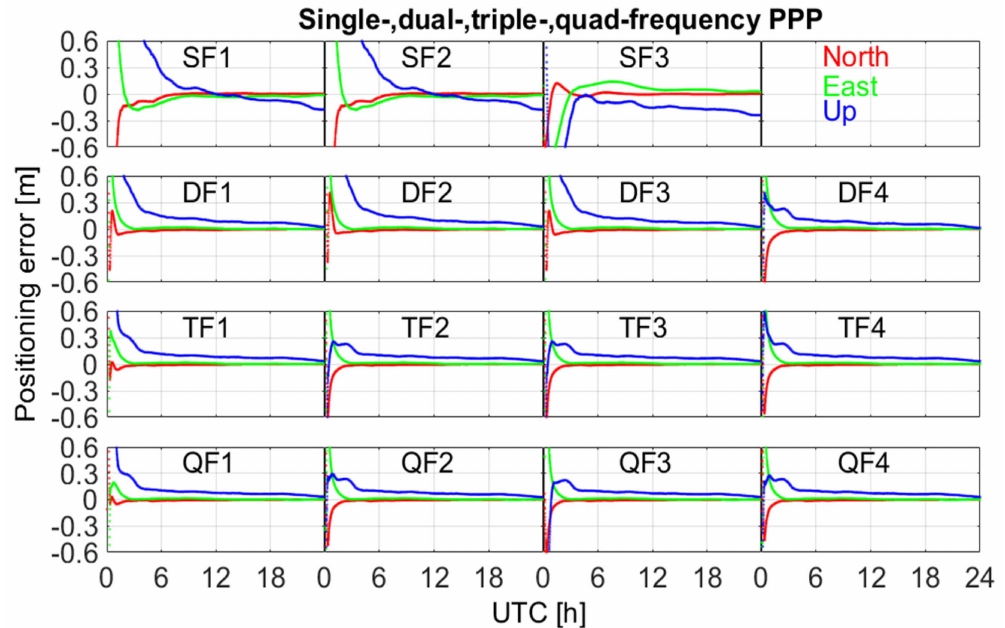
Figure 3. Errors of single-, dual-, triple- and quad-frequency BDS PPP at the iGMAS station KUN1 in the north, east and vertical direction on DOY 16, 2019